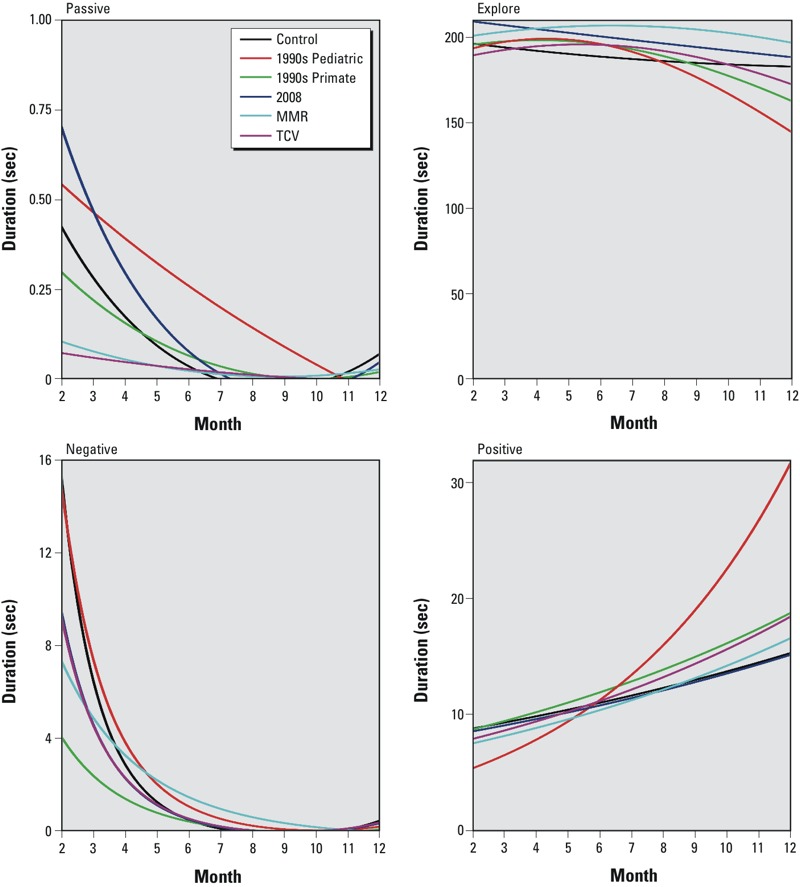
Fitted values from analytical models for non­social behavior for all groups from 2–12 months of age.